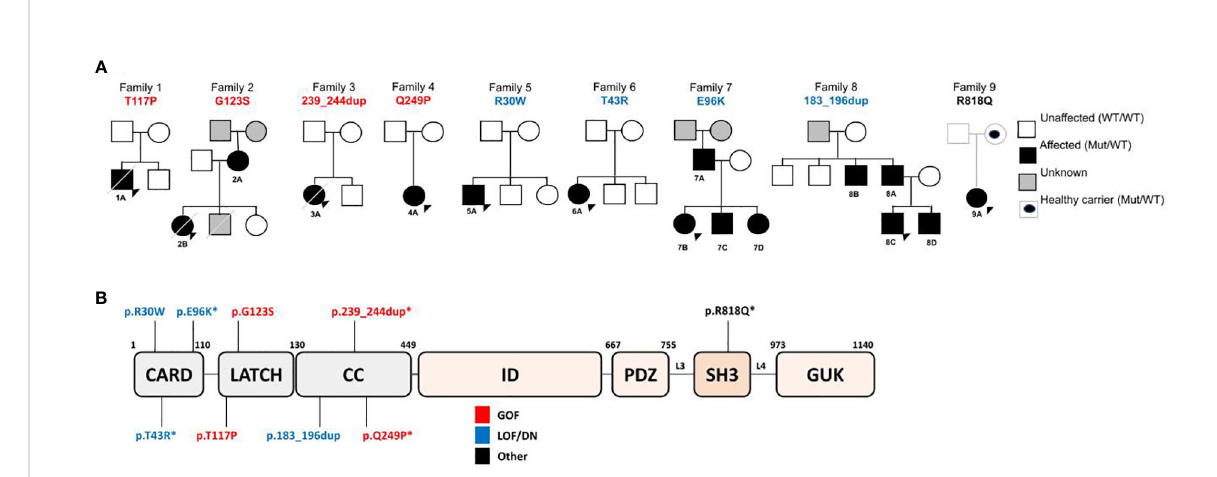
FIGURE 1 (A) Family Pedigrees, with CARD11 variants found and affected family members. (B) Schematic representation of CARD11 protein, with variants found in our